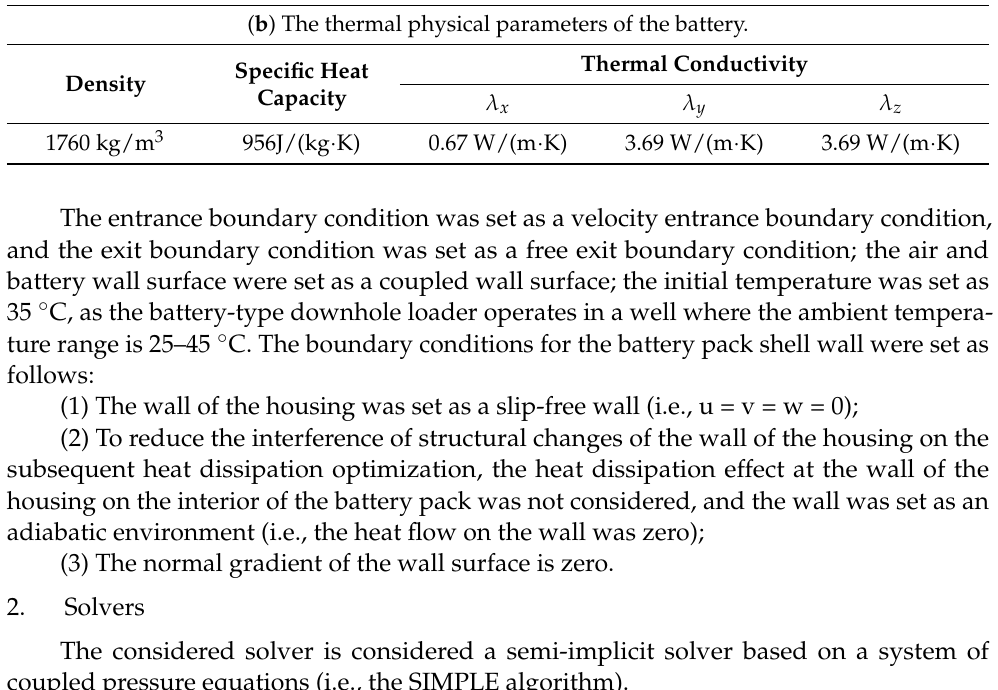
( b ) The thermal physical parameters of the